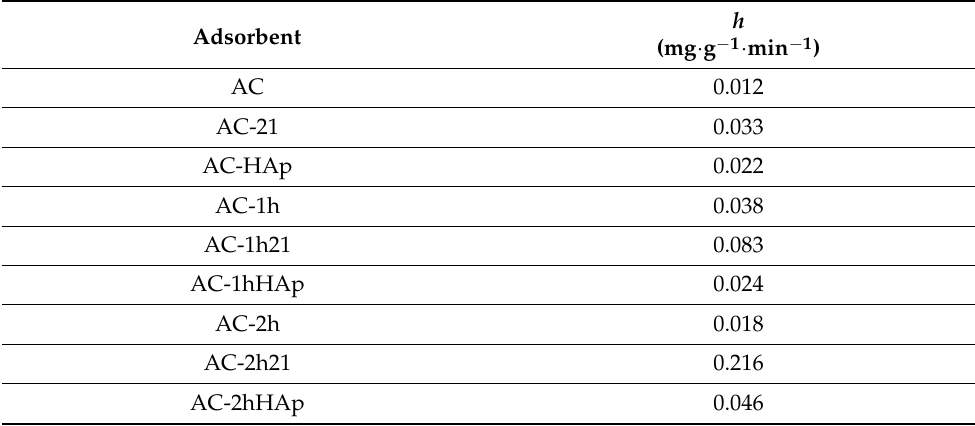
Table 4. Parameters of kinetic models.